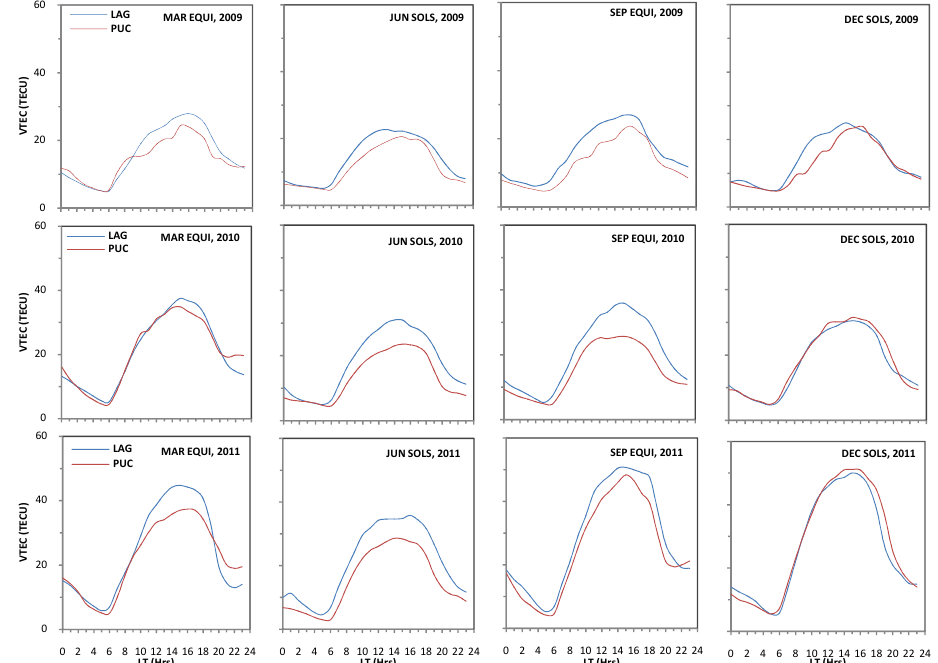
Fig. 1. Diurnal variation of the mean VTEC values for all seasons at Lagos and Pucallpa stations during 2009, 2010, and 2011 respectively.